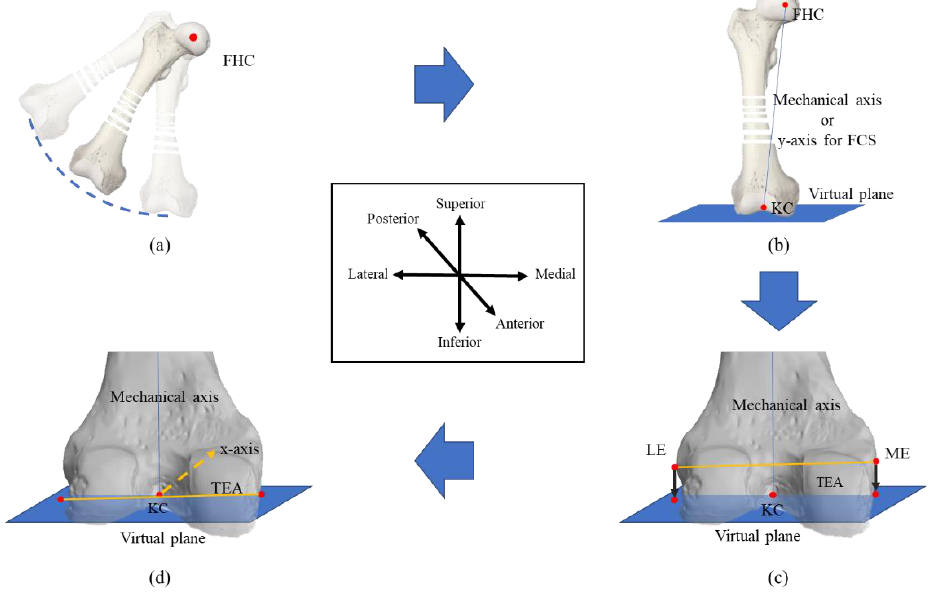
Figure 2. Generalized methodology to assign FCS using key anatomical points [41,42]. ( a ) FHC, ( b ) Mechanical axis and virtual plane, ( c ) Transverse axis, ( d ) Cross product